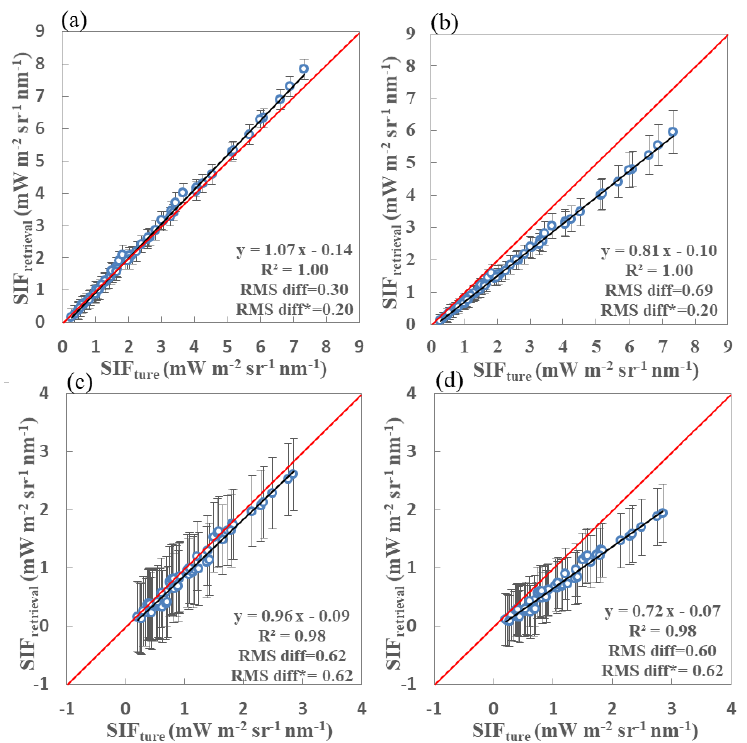
Figure 13. Comparisons between SIF retrievals using the true upward transmittance ( a , c ) and that using the effective upward transmittance ( b , d ) calculated by Equation (3) at both far-red ( upper panels ) and red bands ( bottom panels ). Similar to Figure 12, simulations with SR of 0.3 nm and SNR 322 are used.